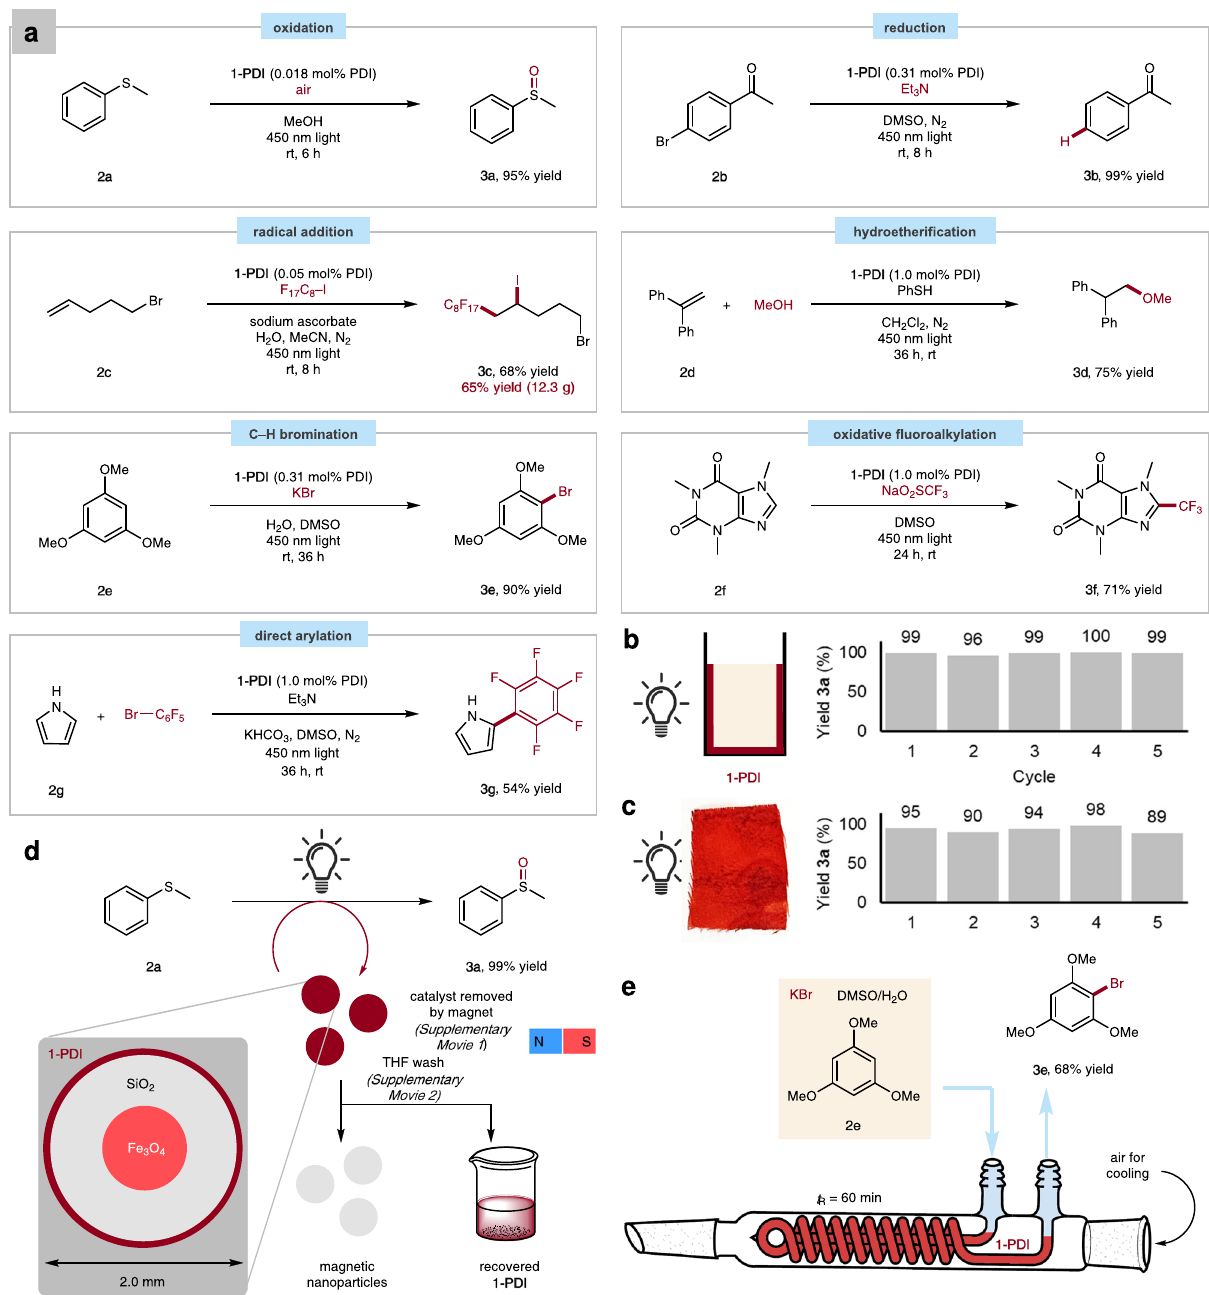
Fig. 3 Synthetic applications of porous-polymer photocatalyst. a Performance of 1-PDI across various reaction classes. b Recyclable usage of 1-PDI as a coating on a glass vial in the photo-oxidation of 2a . c Recyclable usage of 1-PDI deposited on cotton in the photo-oxidation of 2a . d Coated superparamagnetic silica nanoparticles. e Continuous- fl ow synthesis using a fi lm of 1-PDI in glass